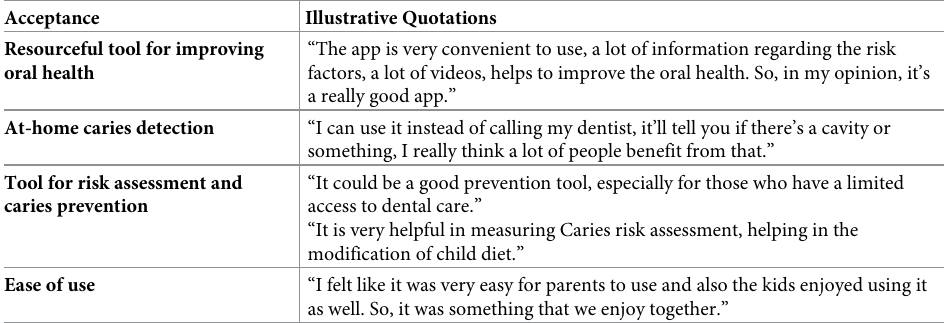
Table 3. Illustrative Quotations from participants on the acceptance of AICaries.